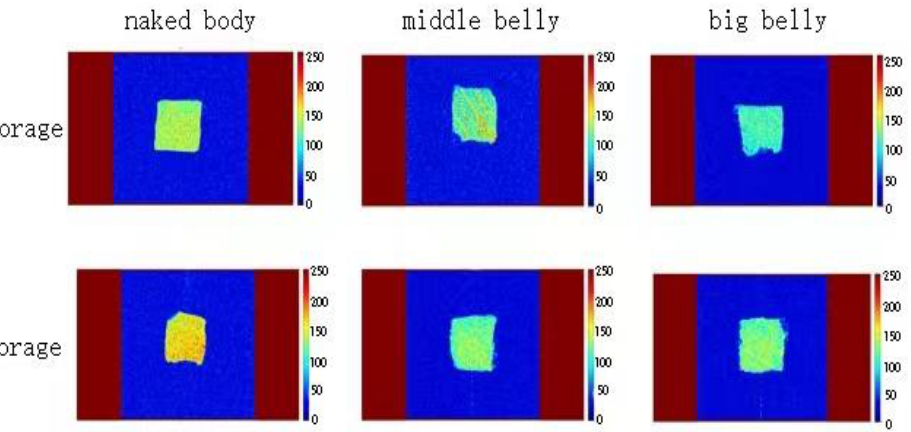
Figure 7. The pseudo color images of different parts of tuna frozen at different